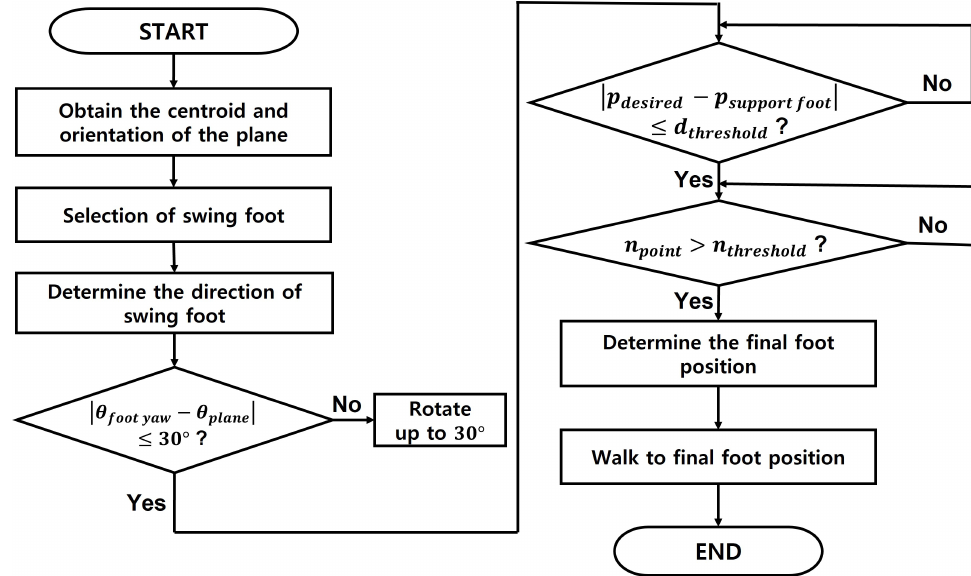
Figure 6. The flow chart of the moving strategy.